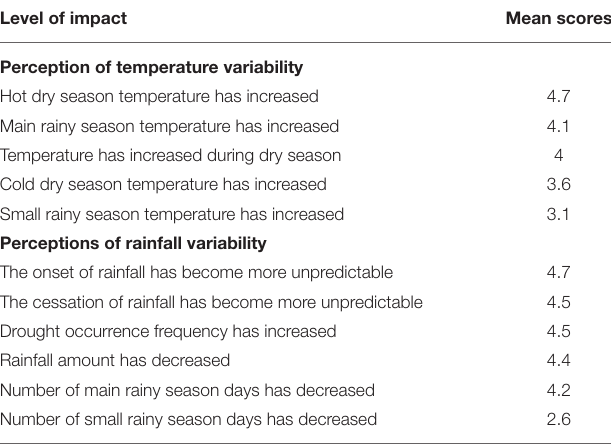
TABLE 1 | Perception of climate change impacts among pastoralists and livestock